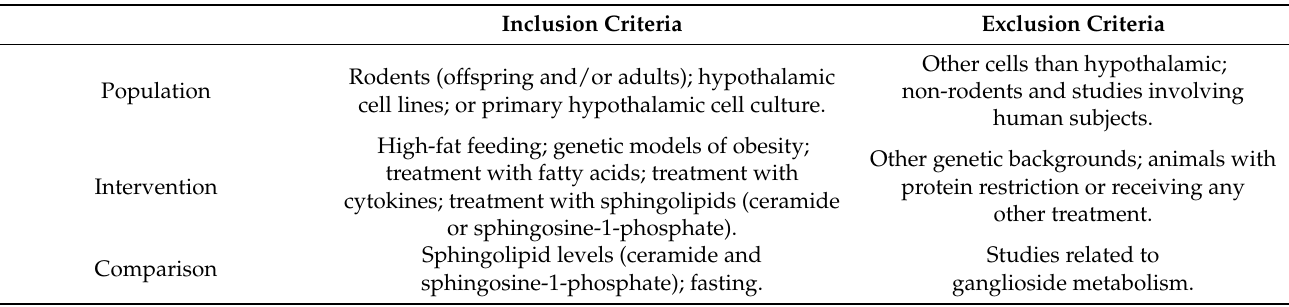
non-rodents and studies involving human subjects. Other genetic backgrounds; animals with protein restriction or receiving any other treatment. Studies related to ganglioside